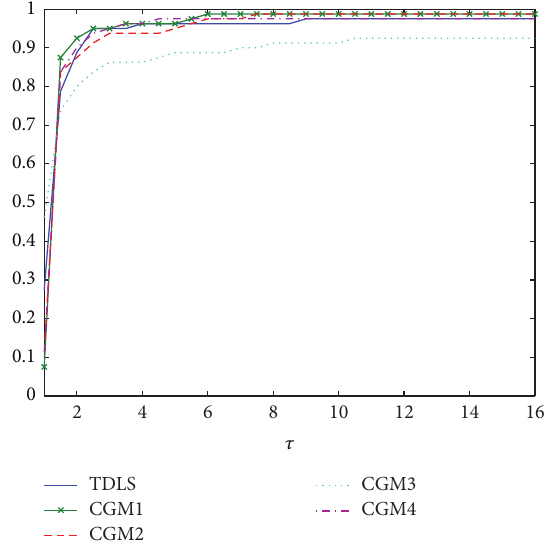
Figure 3: Performance profile based on the CPU